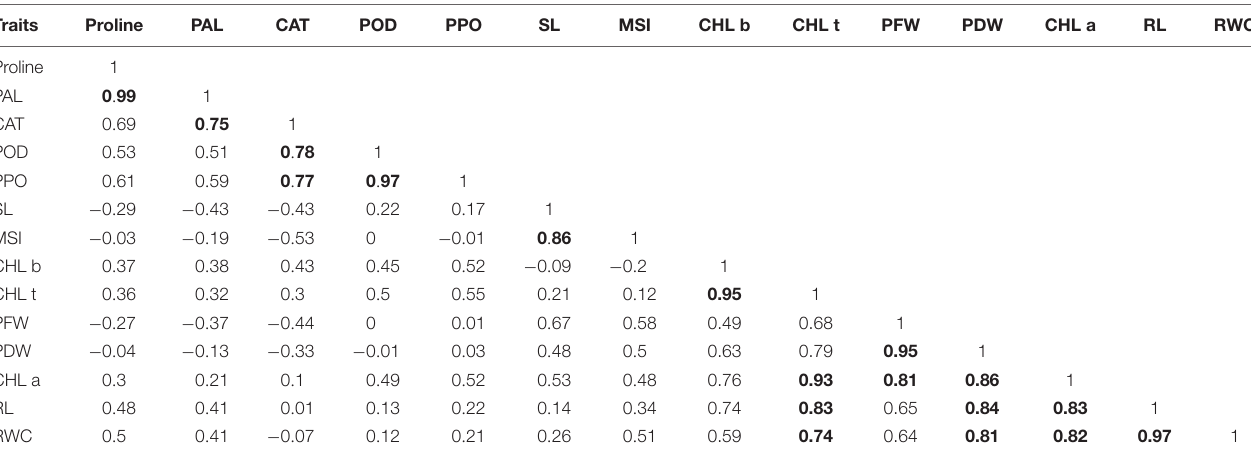
TABLE 6B | Correlation matrix for morphological and physio-biochemical traits during later-stage water stress in a pot experiment under net house conditions. Traits Proline PAL CAT POD PPO SL MSI CHL b CHL t PFW PDW CHL a RL RWC